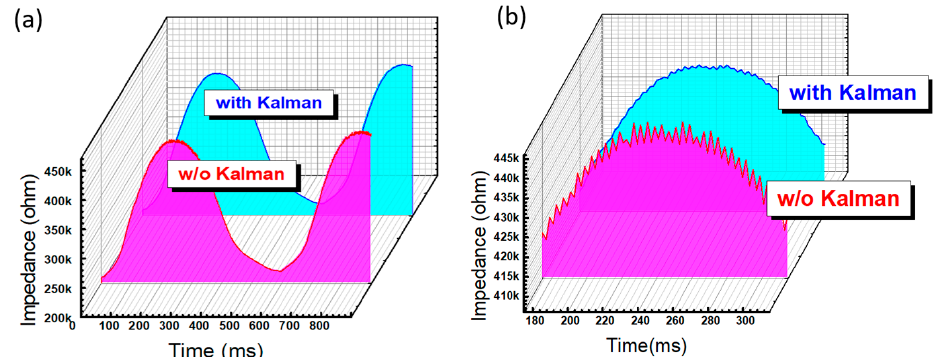
Figure 5. Time-dependent response of the single flexible pressure sensor with a regular pressing force and 24% duty cycle: ( a ) without and ( b ) with the Kalman filter.